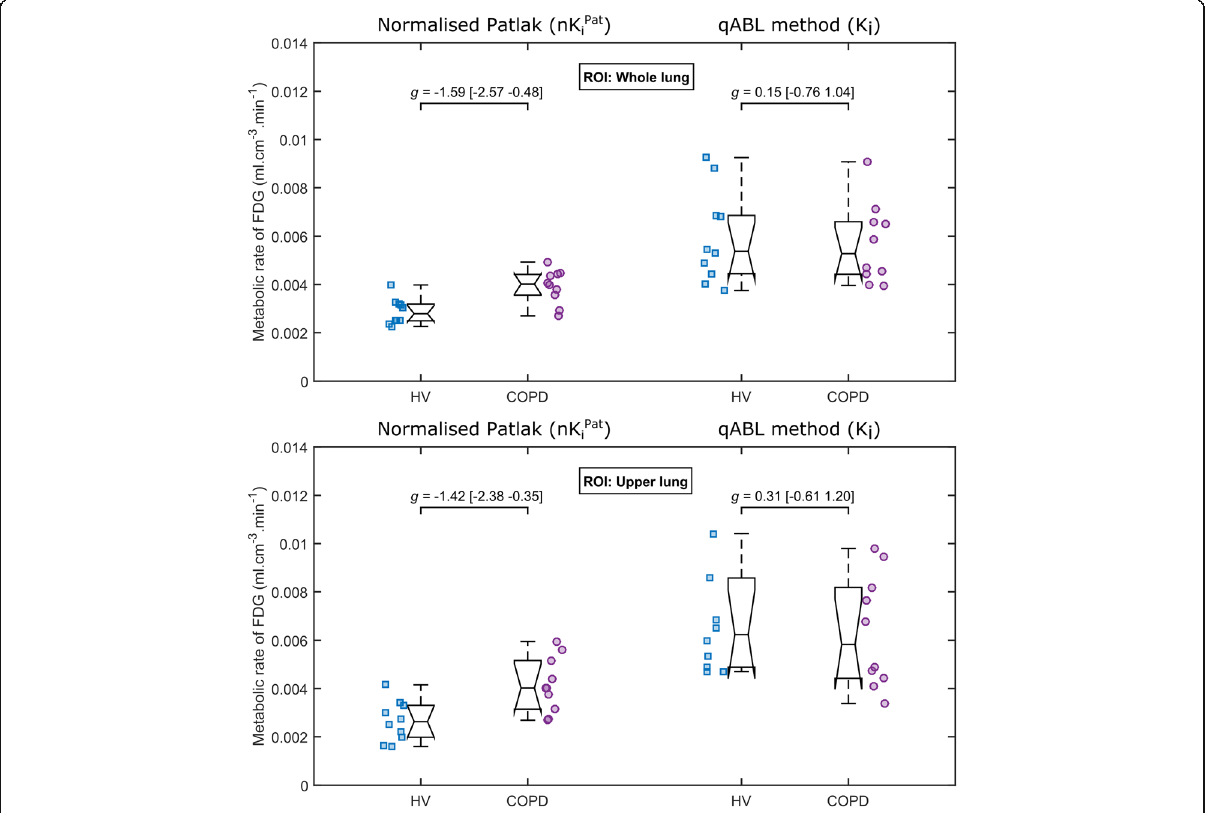
Fig. 4 Metabolic rate of 18 F-FDG in the whole lung ( top ) and the upper lung ( bottom ) estimated with normalised Patlak ( left ) and qABL method ( right ) in HV and COPD cohorts. Individual points are plotted together with median, q 1 (first quartile) and q 3 (third quartile). Whiskers extent: q 3 − 1.5 * ( q 3 − q 1 ) for the low boundary and q 3 + 1.5 * ( q 3 − q 1 ) for the high